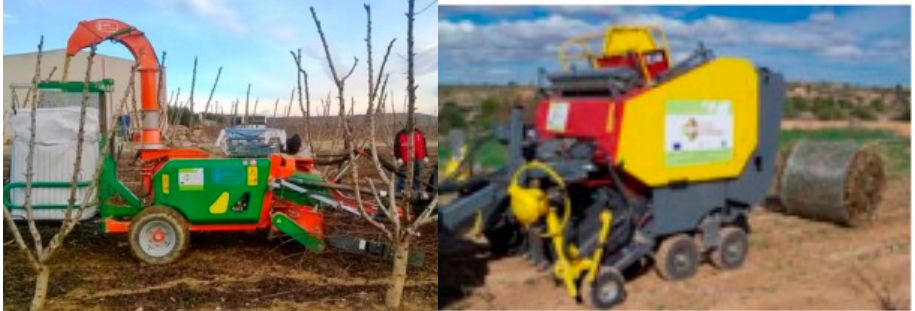
Figure 6. Examples pruning harvesting with chipping and baling systems: pruning chipper ( left ) and pruning baler ( right ) [25].